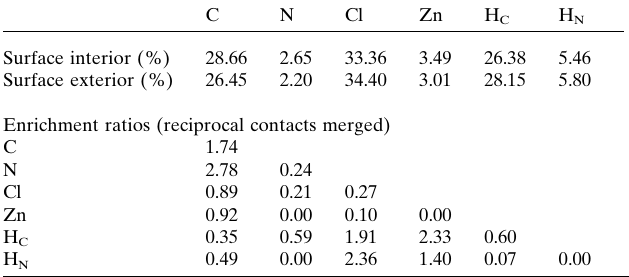
Table 4 Hirshfeld contact surfaces and ERs for (44TPH 3 ) 2 [ZnCl 4 ] 3 computed around the two (44TPH 3 ) 3+ cations and the three [ZnCl 4 ] 2 (cid:3) anions. The H atoms bound to carbon (H C ) and nitrogen (H N ) are differentiated. The first column corresponds to ‘interior’ atoms and the remaining columns to ‘exterior’ ones.